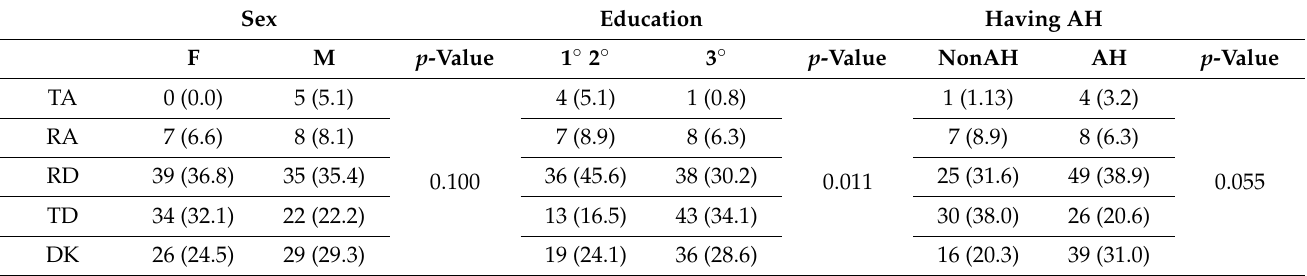
Table 11. Moderate daily physical activity as a factor that increases the incidence of hypertension by gender, education, and having hypertension (N =